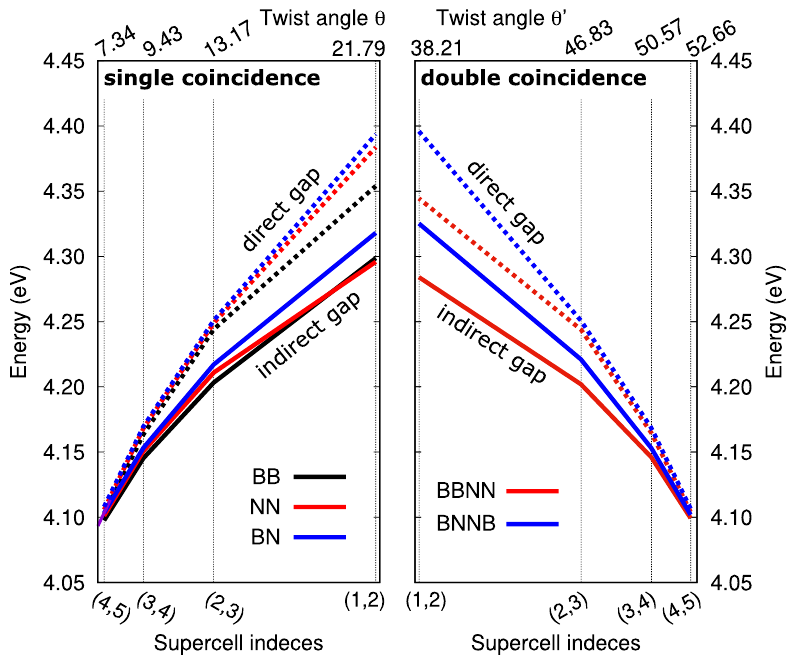
Figure 4: Indirect gap (solid lines) and direct gap (dashed lines) of the five stackings as a function of the twist angle ( θ or θ ′ depending on the stacking) within the δ = 1